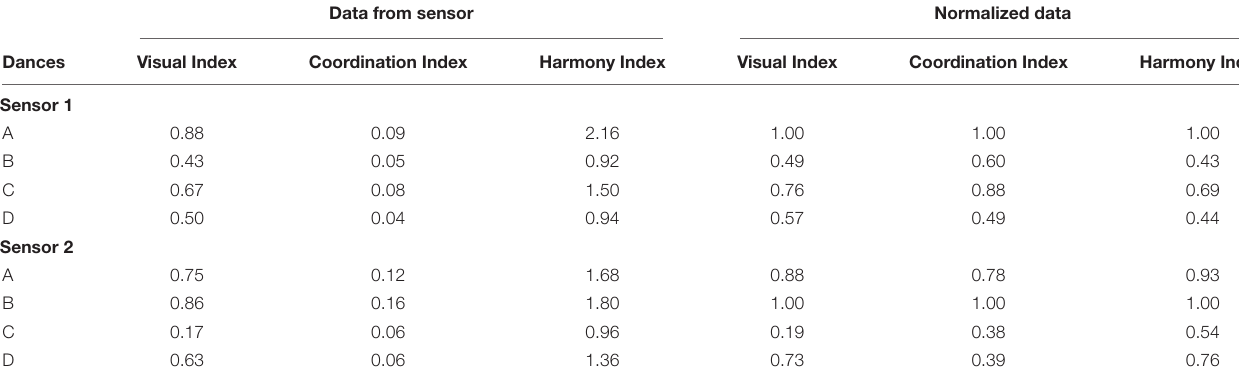
FIGURE 7 | Comparison between video images and sensor captured data. TABLE 1 | Harmony Index, Coordination Index, and Visual Index from sensor 1 and sensor